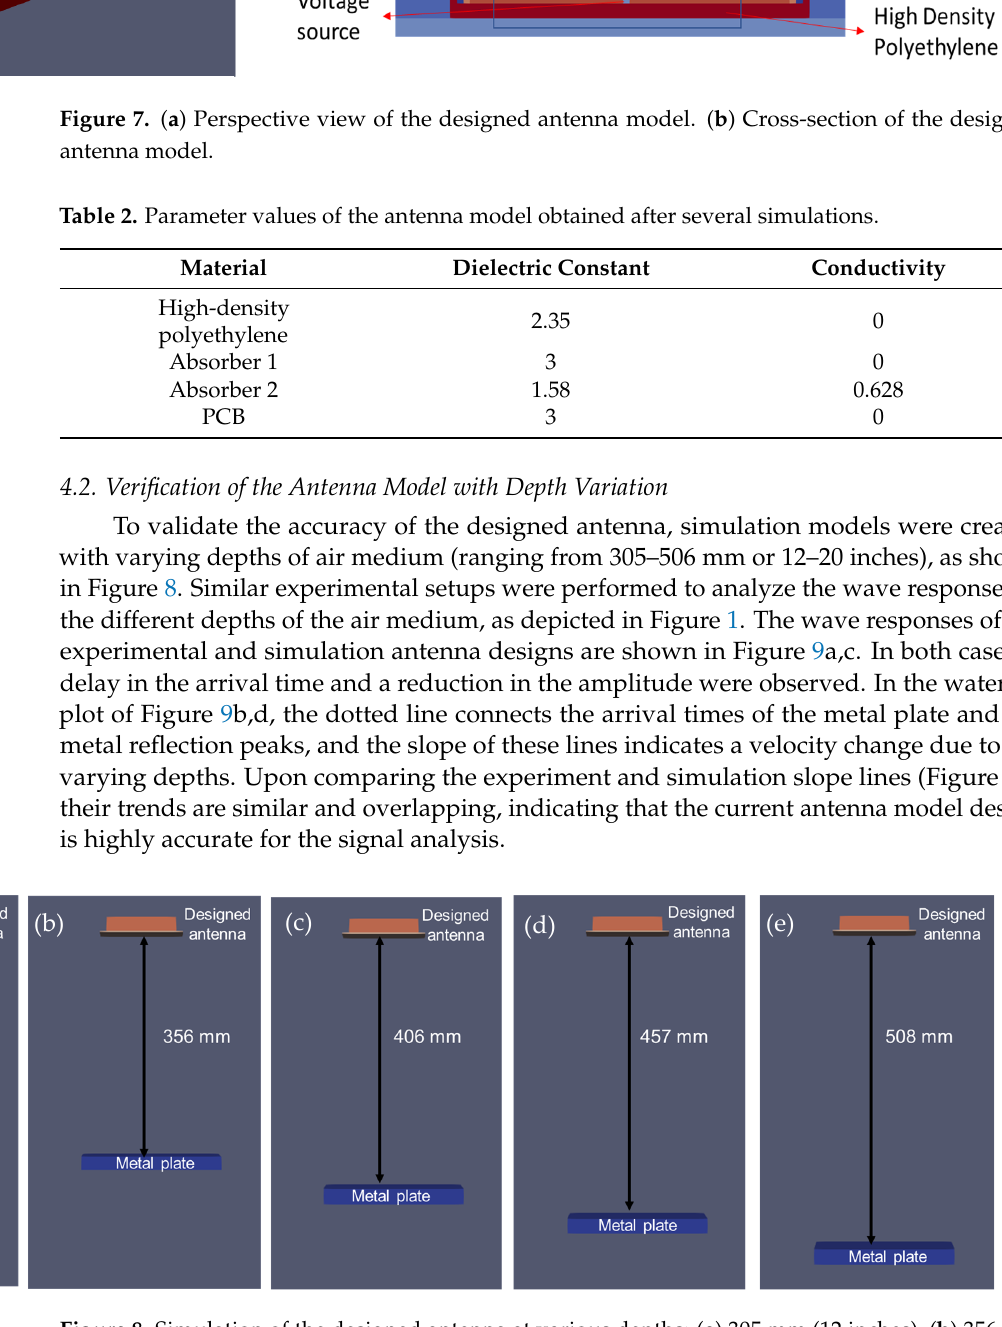
Figure 9. Data comparison: wave response analysis in air at di ff erent depths (305–506 mm) for ( a ) experiment and ( c ) simulation, and waterfall plots for peak amplitude and boundary of metal re- fl ection from ( b ) experiment and ( d ) simulation. Figure 10. Comparison of slope lines similarity between simulation and experiment.